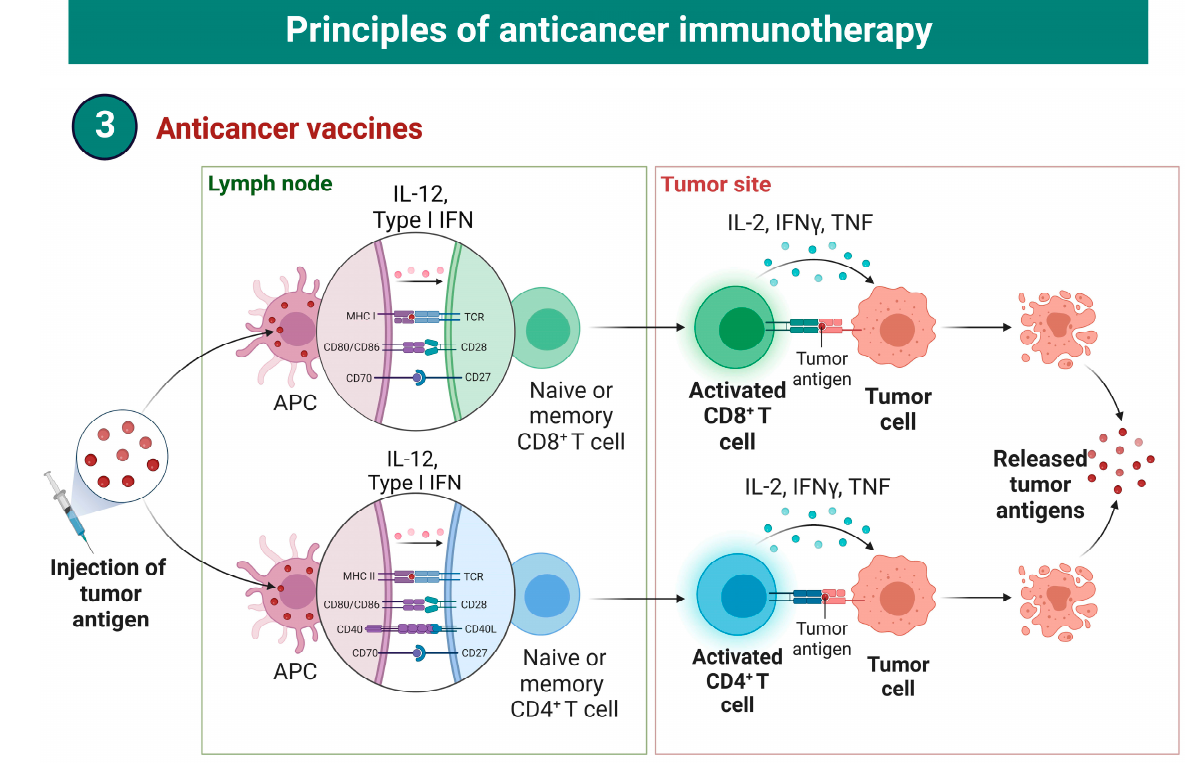
Figure 3. The overview of cancer vaccines’ mechanisms. MHC—major histocompatibility complex; CD—cluster of differentiation; APC—antigen-presenting cell; IL—interleukin; IFN—interferon.